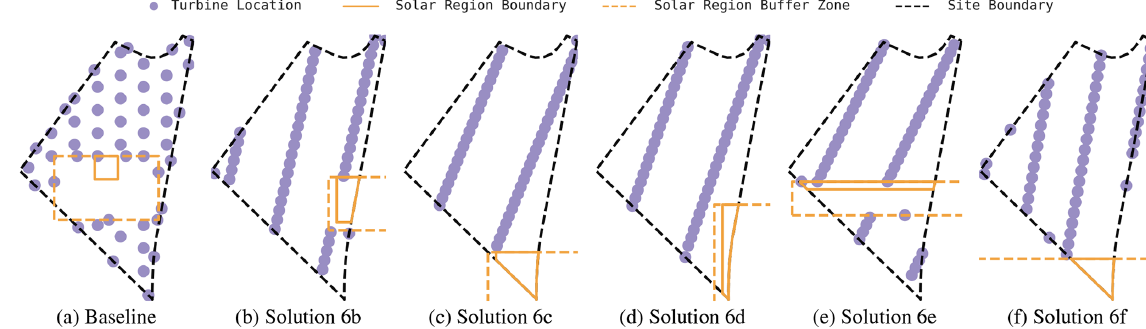
Figure 7. CMA-ES solutions for the high-correlation location and irregular boundary.